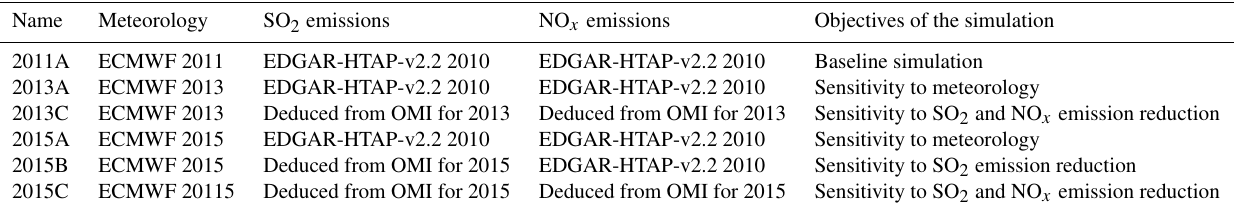
Table 2. Description of the different experiments performed with the regional chemistry-transport model